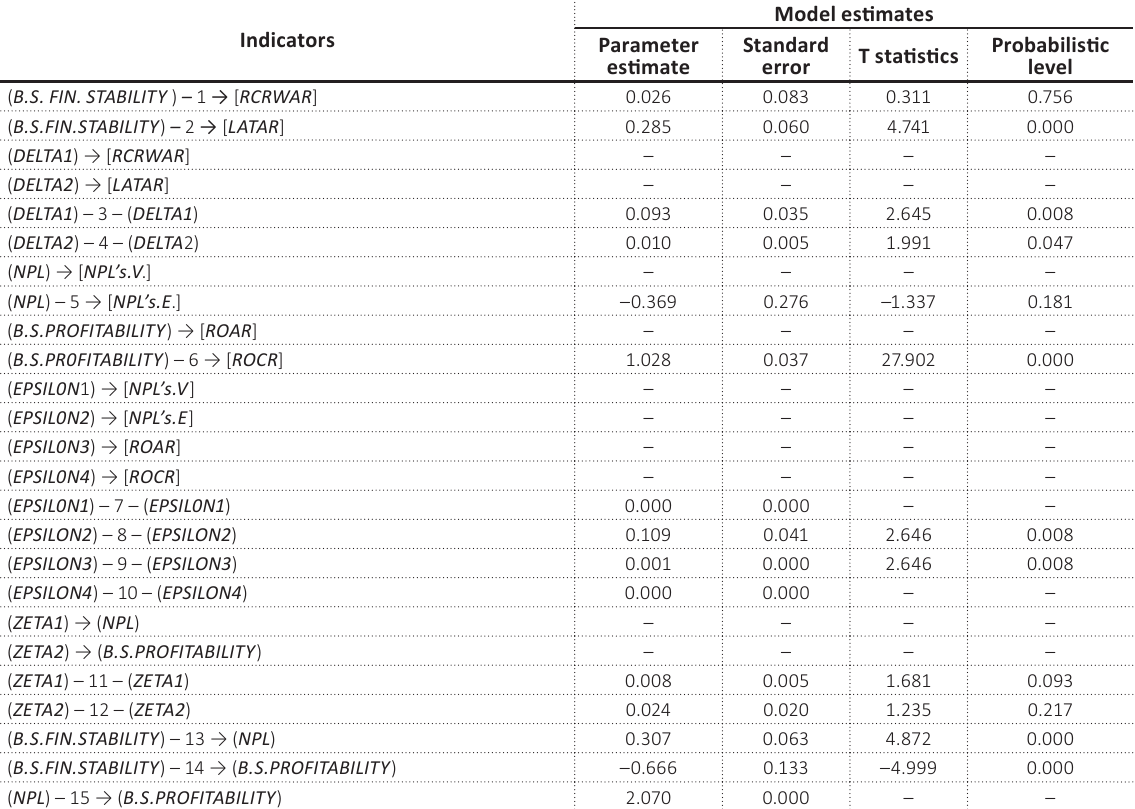
Table 4. The results of structural modeling of the relationship between nonperforming loans of banking institutions, profitability and financial stability of the Ukrainian banking